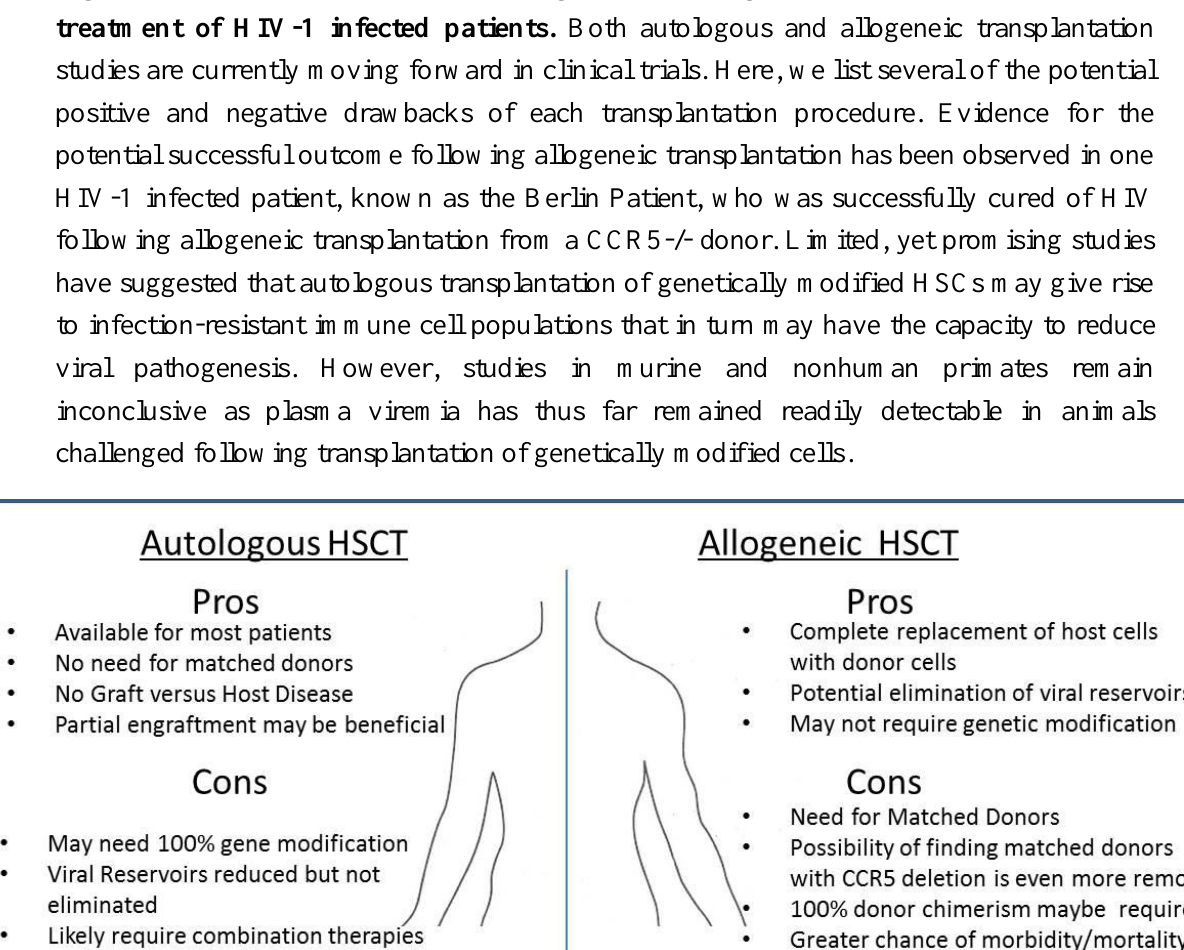
Figure 1. Pros- and Cons- of Autologous and Allogeneic Transplantation for the treatment of HIV-1 infected patients. Both autologous and allogeneic